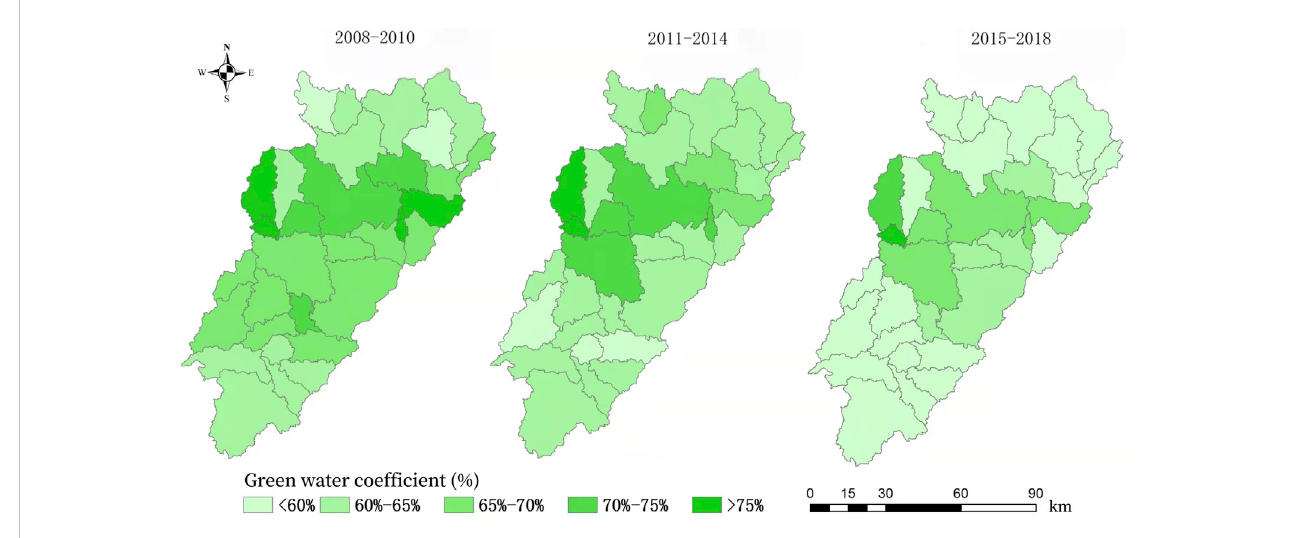
FIGURE 8 Spatial distribution of green water coef fi cient in the Meijiang River Basin.